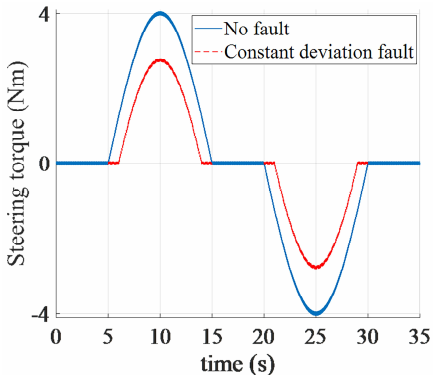
Figure 3. Constant deviation fault.